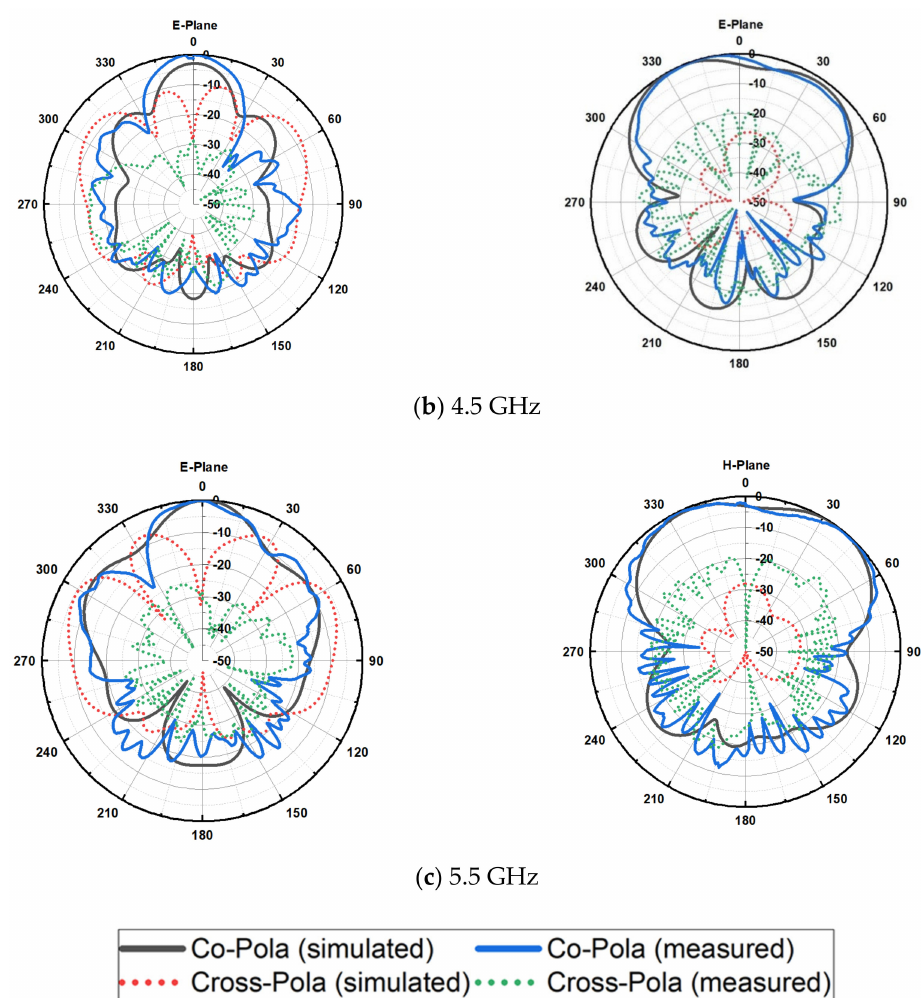
Figure 16. Simulated and measured E-field and H-field radiation patterns showing co-polarization and cross-polarization of the wideband array antenna with the FSS single layer reflector at: ( a ) 3.5, ( b ) 4.5, and ( c ) 5.5